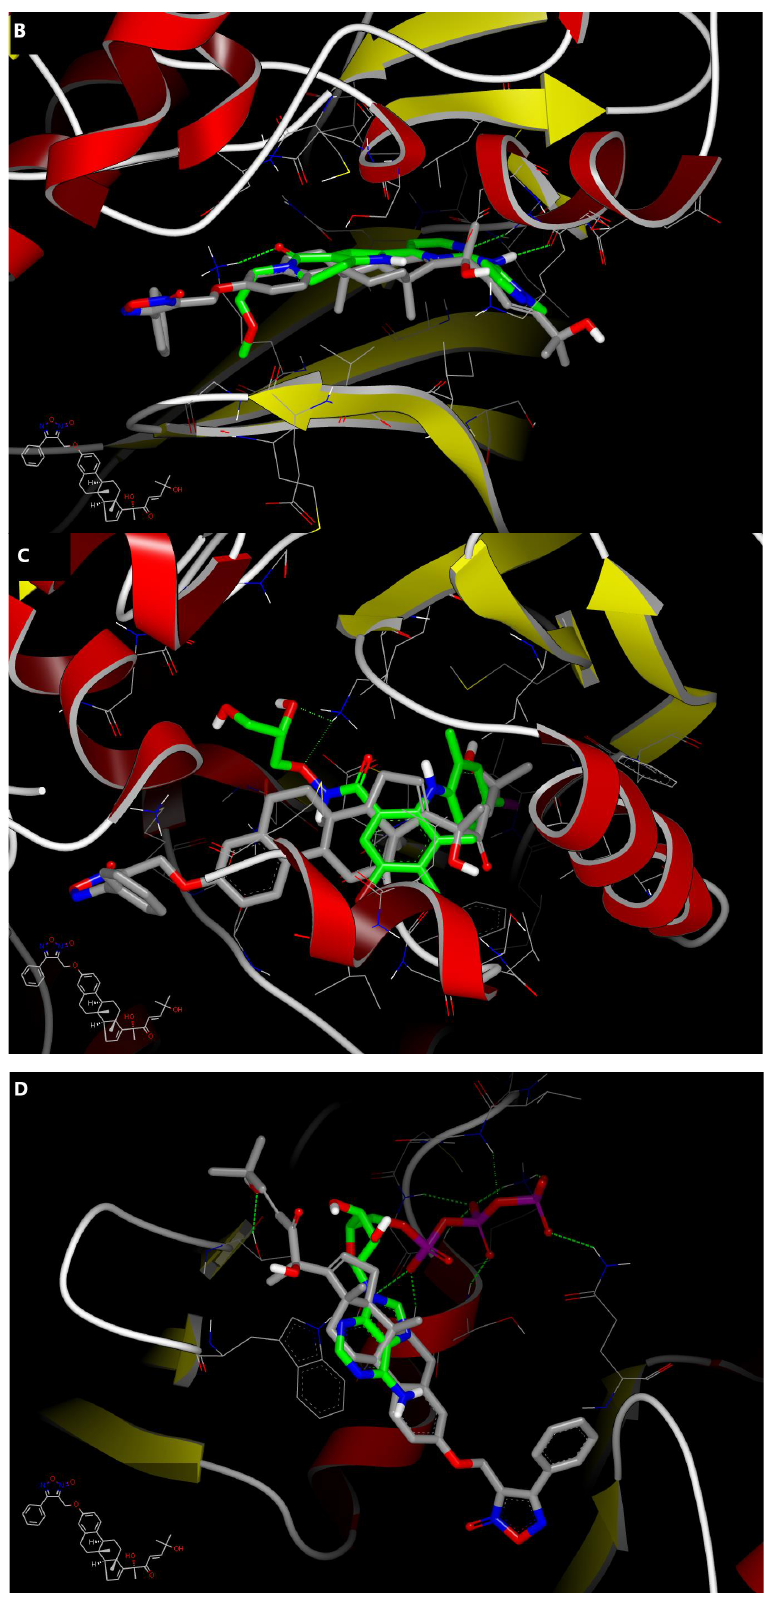
Figure 8. Visual representation for ( A ) erlotinib (green), 14a (grey), and NO-CIEA I (yellow) overlay docked with EGFR showing hydrophobic – hydrophobic interactions and hydrogen bonds (green dash lines) towards ATP-binding site, ( B ) overlay of 14a (grey) and co-crystallized ligand (green ) docked with Erk2 showing hydrophobic – hydrophobic interactions, ( C ) overlay of 14a (gray), and co-crystallized ligand (green ) docked with MEK1 showing hydrophobic – hydrophobic interactions, ( D ) overlay of 14a (gray) and co-crystallized ligand (green ) docked with MRP1 showing hydropho- bic – hydrophobic interactions and hydrogen bonds (green dash line) towards the active site.